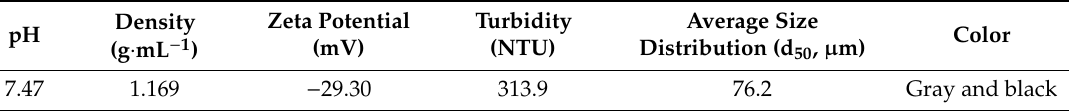
Table 2. The properties of the coal mine wastewater used in the